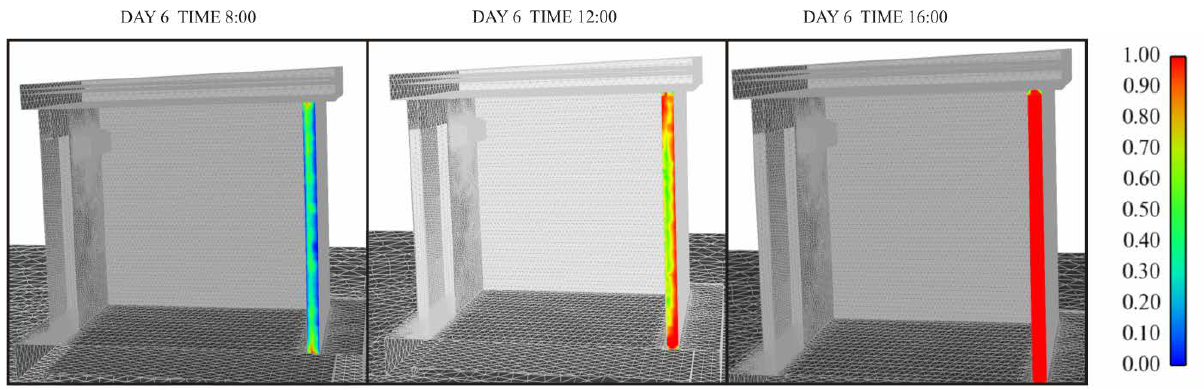
Figure 17. Evolution of the PCM liquid fraction in the south